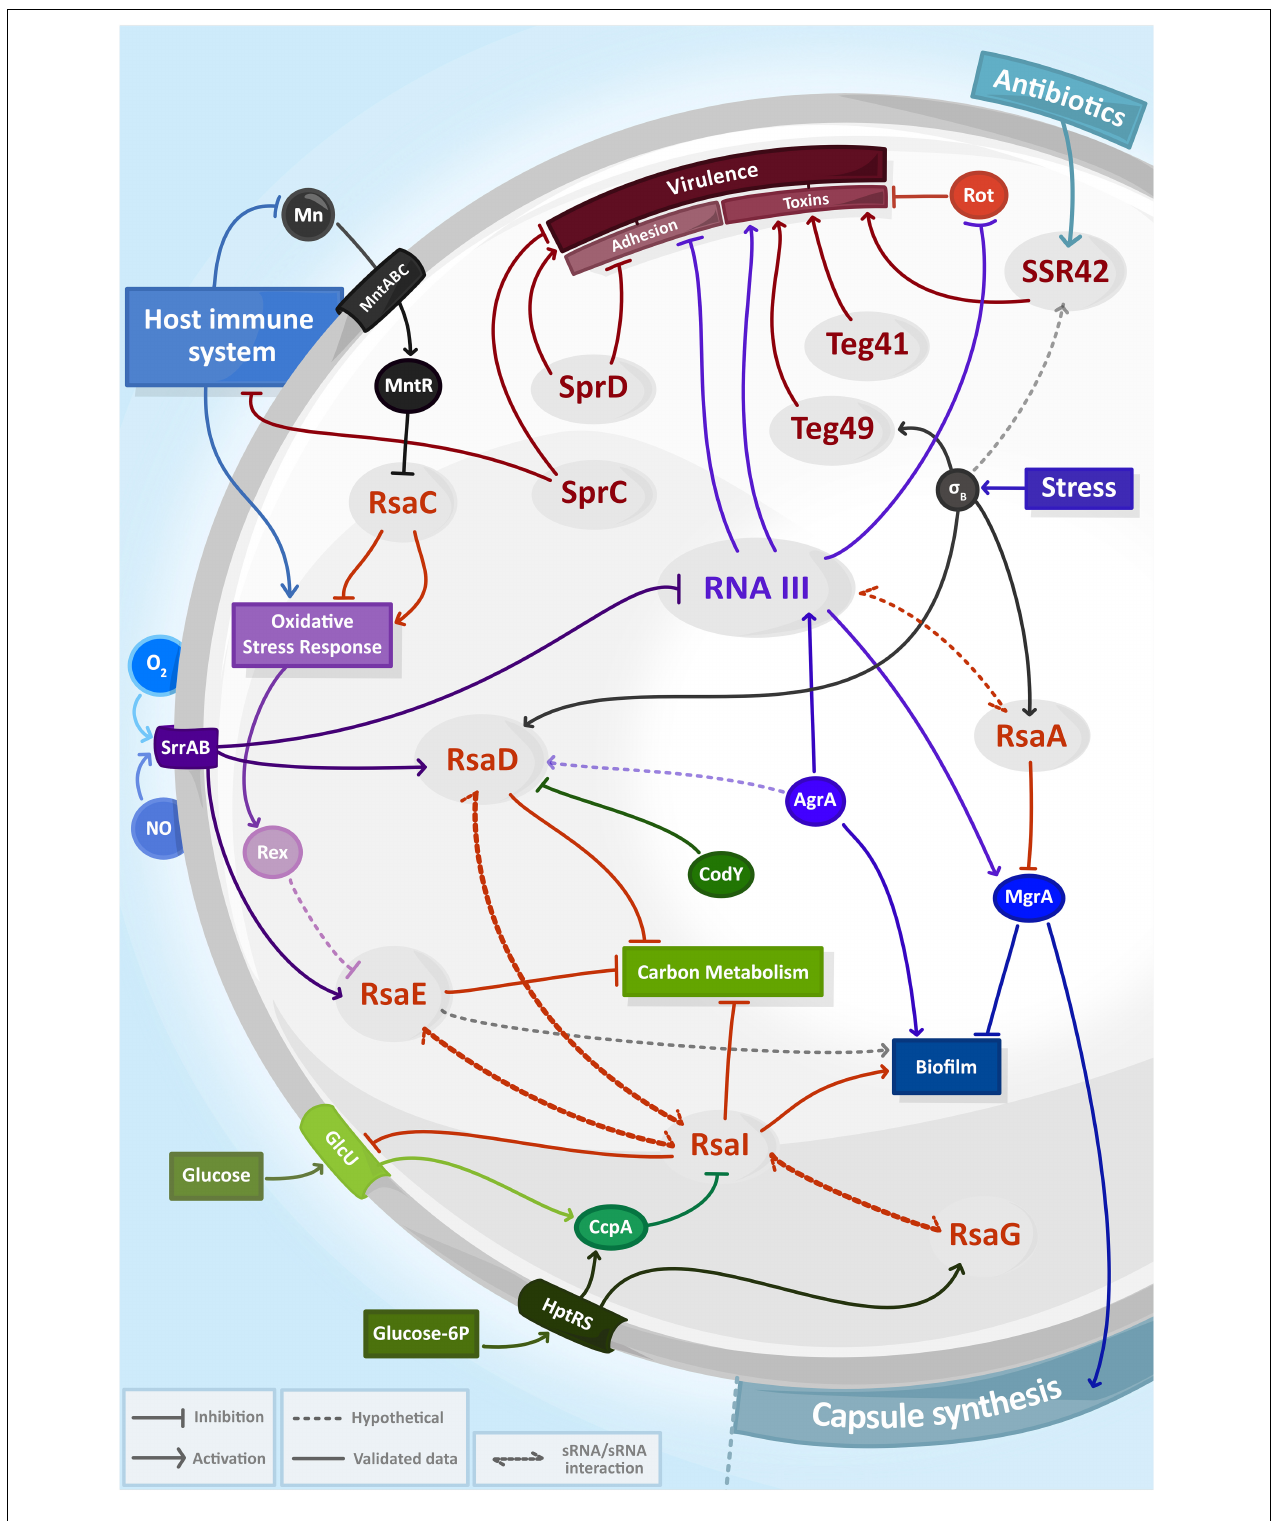
FIGURE 1 | The complexity and entanglement of regulatory RNA (sRNA) networks in Staphylococcus aureus . Expression of sRNAs (in gray circles) are induced by environmental signals including antibiotics, host immune system responses, exposure to reactive species (NO, O 2 − ) and nutrient availability. Together with transcriptional factors (solid circle) or two-component systems, sRNAs control capsule synthesis, biofilm production, carbon metabolism, oxidative stress response or virulence and then form intricate regulatory networks.